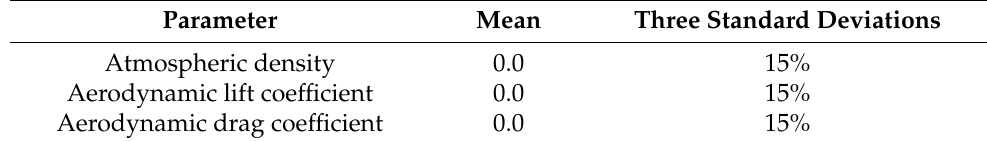
Table 1. Model deviations for Monte Carlo simulations.